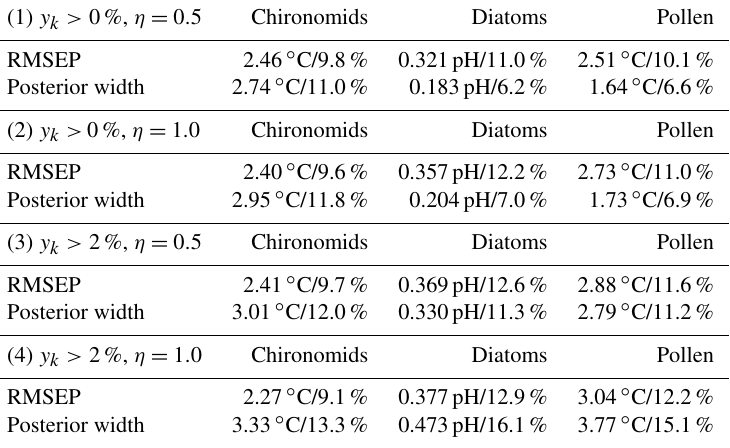
Table 2. Four BUMPER models. For each of the three training sets (Matthews-Bird et al., 2016; Stevenson et al., 1991; Bush et al., 2017) four models are considered. We use either the standard model ( η = 0 . 5 ) or the presence–absence model ( η = 1 . 0 ) and reconstruct with either all taxa ( y k > 0%), or only including taxa with more than 2% abundance ( y k >